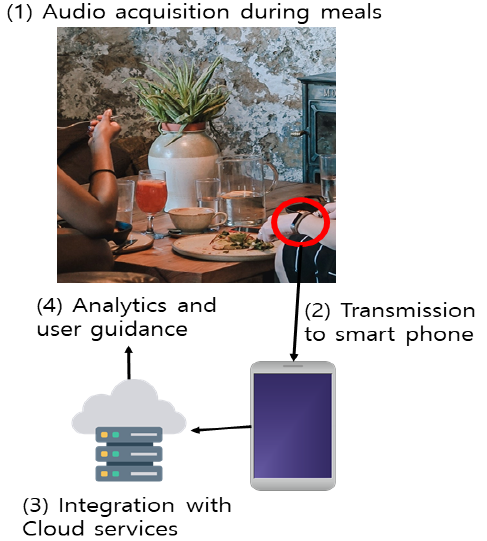
Figure 2. A high level architecture of the proposed system.